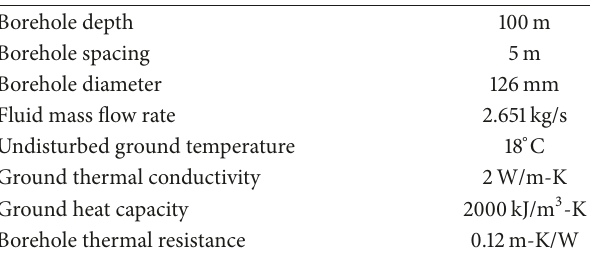
Table 4: Simulation input data.